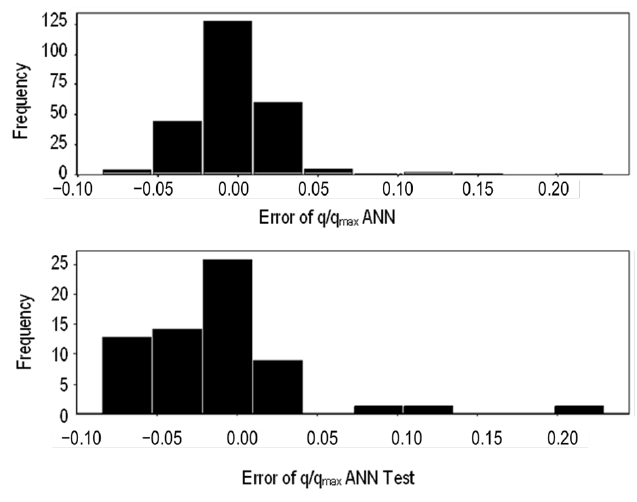
Figure 9. Error distribution for ANN model.